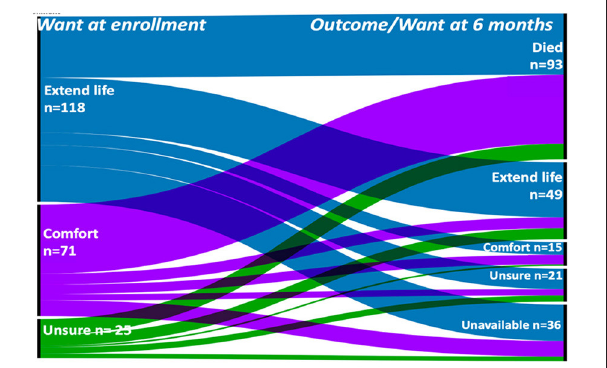
FIGURE 2 | Alluvial diagram illustrating Change in prioritized goals over time. Families were asked what goals of care the patient would prioritize at enrollment (“Want at enrollment,” left boarder) and 6 months later (“Outcome/Want at 6 months,” right boarder). At 6 months, we had 85 survivors, 93 decedents and 36